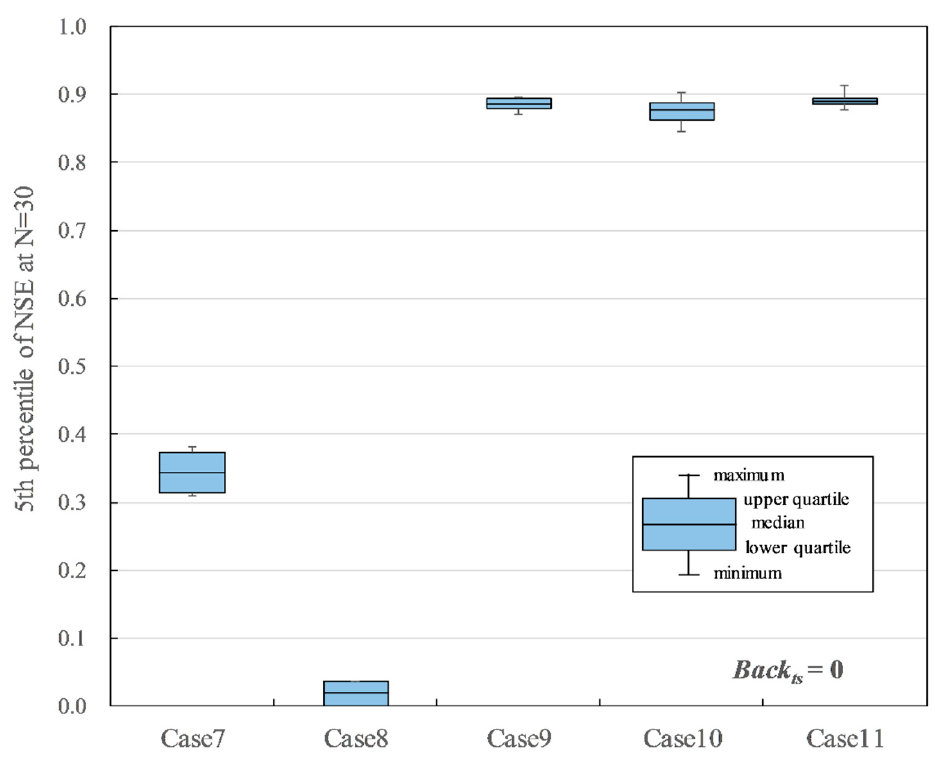
Figure 11. Summarized training results for Case 7 to Case 11 when Back ts = 0, Drp = 0, Drp r = 0. Two trainings of Case 1 ( Back ts = 24, Hid = 20, Drp = 0, Drp r = 0 ) and Case 8 ( Back ts = 24, Hid = 20, Drp = 0, Drp r = 0 ) were chosen to investigate the impact of precipitation to the estimation results. The hydrograph of observed discharge, precipitation, and both estimation results are shown in Figure 12. The blue line is observed data, and the grey line is precipitation. The green and orange lines represent discharge estimated from data with precipitation and without precipitation, respectively. The hydrograph indicates that both estimation results are responsive to precipitation events. When precipitation data was used for train- ing, there is a trend of an occurrence of trough in the estimated discharge after a peak caused by precipitation. Additionally, the model could not estimate the discharge well when a relatively heavy precipitation event occurs. These are considered as part of the reasons that precipitation may cause lower accuracy.